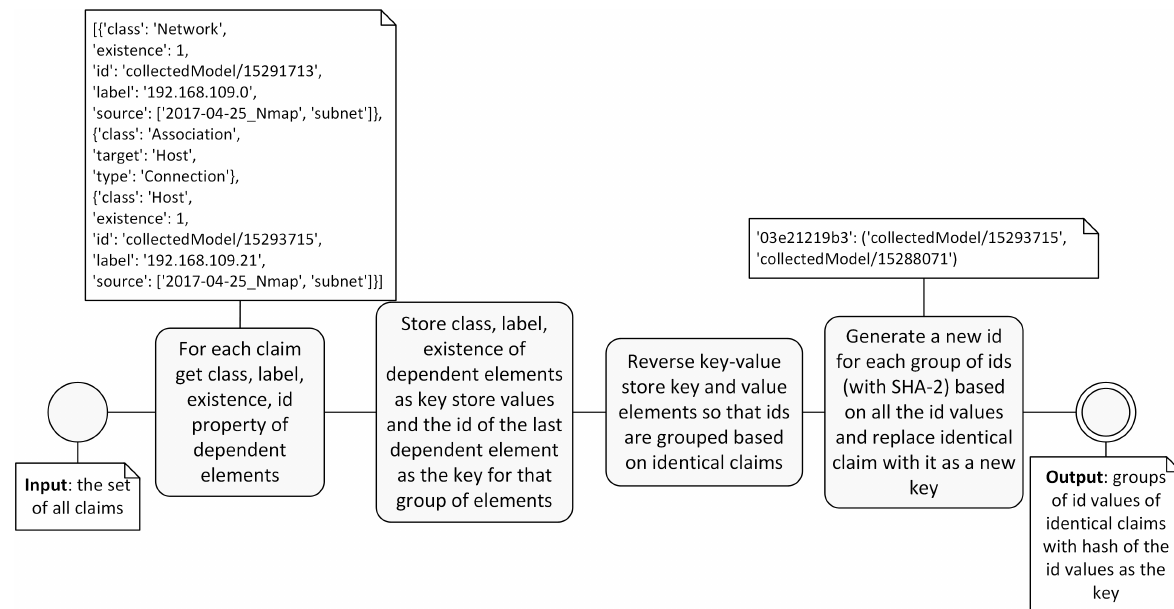
Figure 3. Activity diagram of an algorithm for grouping id values of identical